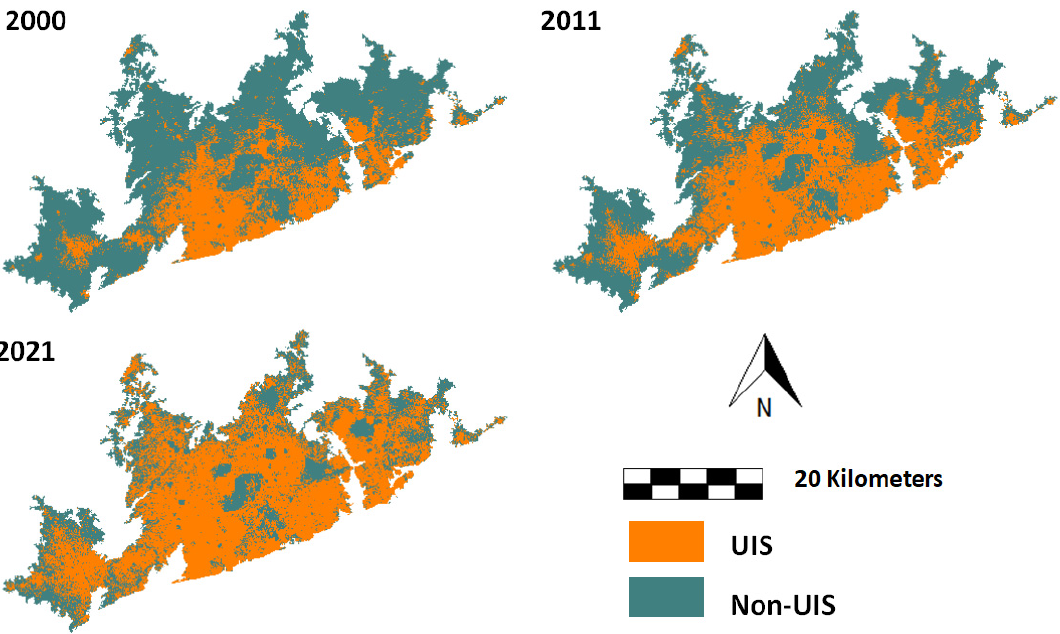
Figure 2. Annual UIS maps for Accra in 2000, 2011, and 2021 ( upper left , upper right, and lower left ), respectively.